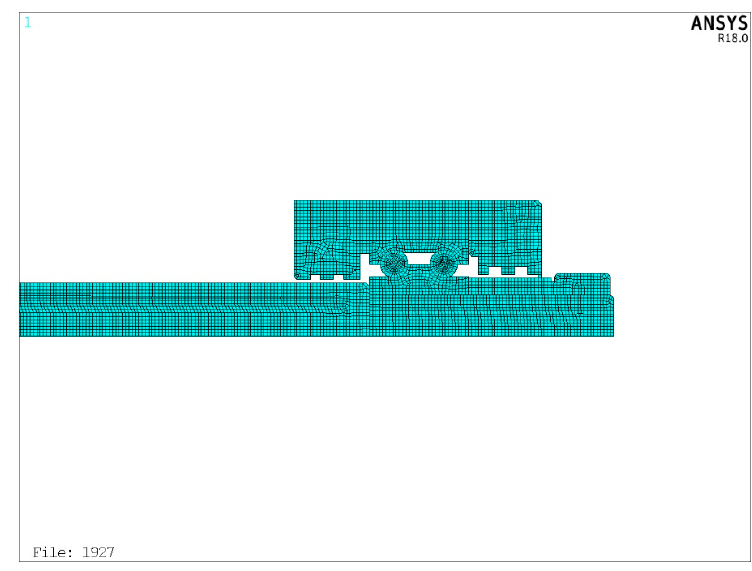
Figure 10. Mesh size of feed system.